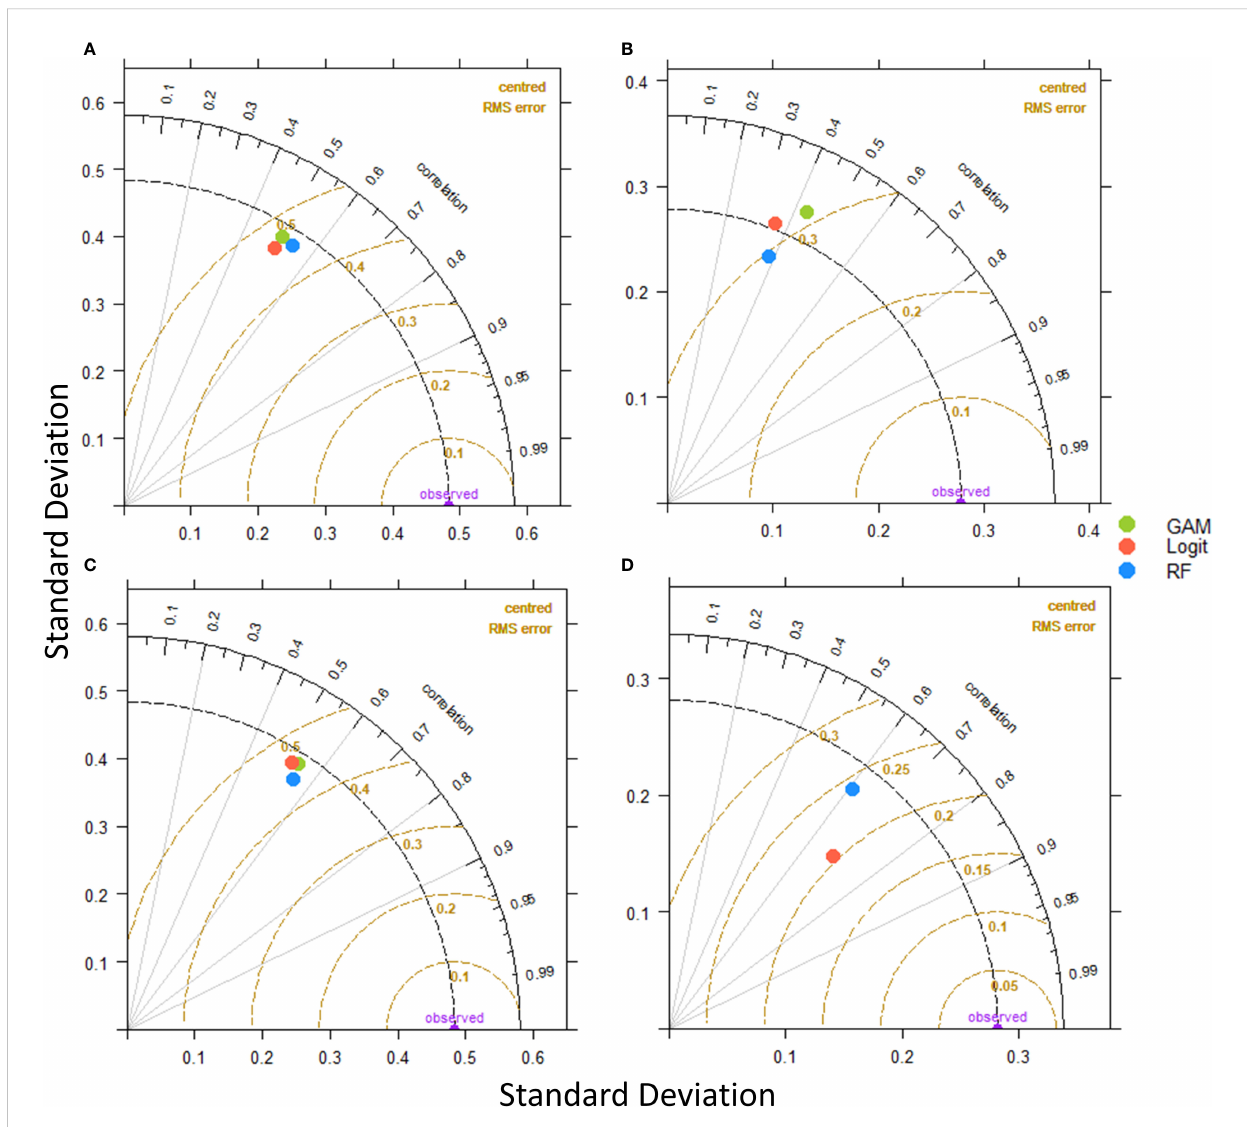
FIGURE 5 Taylor diagrams for Logistic regression, GAMs and Random Forest models comparison. (A) Anchovy in Thracian Sea, (B) Sardine in Thracian Sea, (C) Anchovy in Gulf of Thermaikos and (D) Sardine in Gulf of